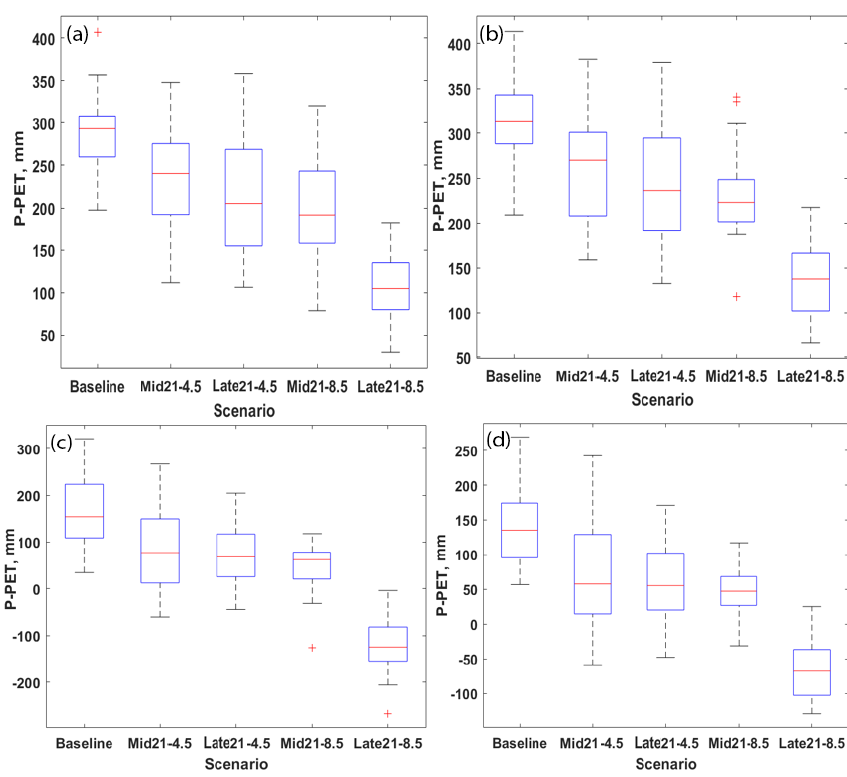
Figure 4. Total annual precipitation minus potential evapotranspiration of 20 GCMs in five wetlands in the SE United States (unit: mm), where (a) is site AR (Alligator River National Wildlife Refuge in North Carolina), (b) is site LP (loblolly pine plantation in North Carolina), (c) is site FL–UP (upland in Florida) and site FL–WET (wetland in Florida), and (d) is site SC (wetland in South Carolina). The baseline